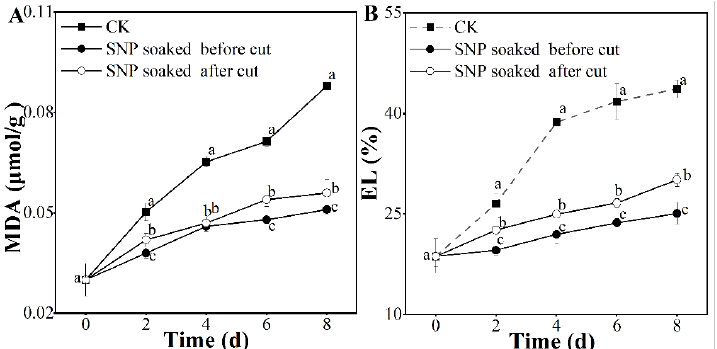
Figure 3. Effect of SNP treatment on membrane integrity of fresh-cut potatoes. MDA ( A ) and EL ( B ). Different letters indicate significant differences among treatments at same storage time ( p < 0.05).